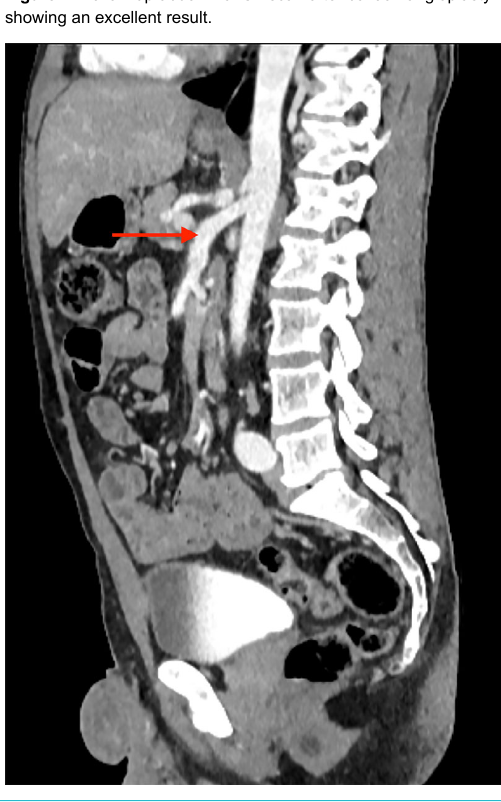
invasive procedures must be used only for life-threatening situations, due to high rates of